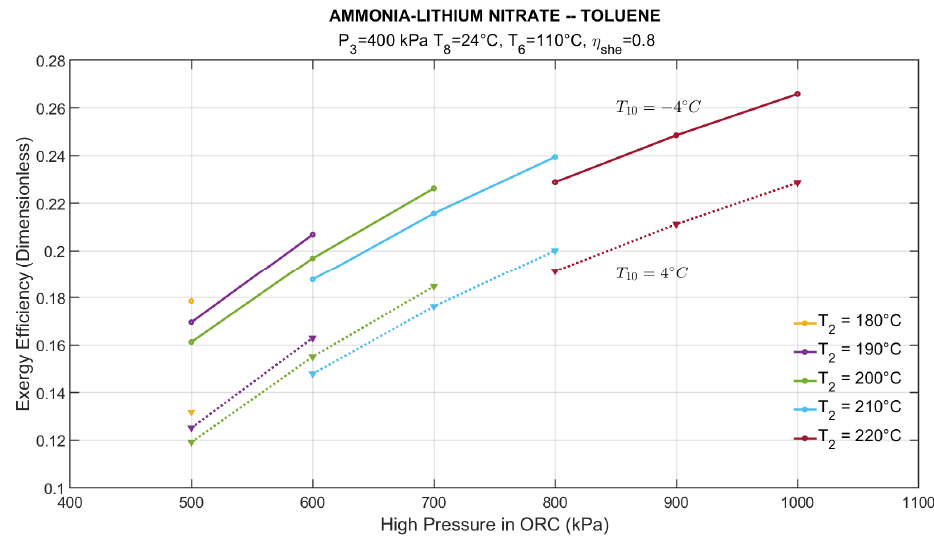
Figure 18. NH 3 -LiNO 3 –C 7 H 8 exergy efficiency as a function of heat supply temperature and maxi- mum ORC pressure.